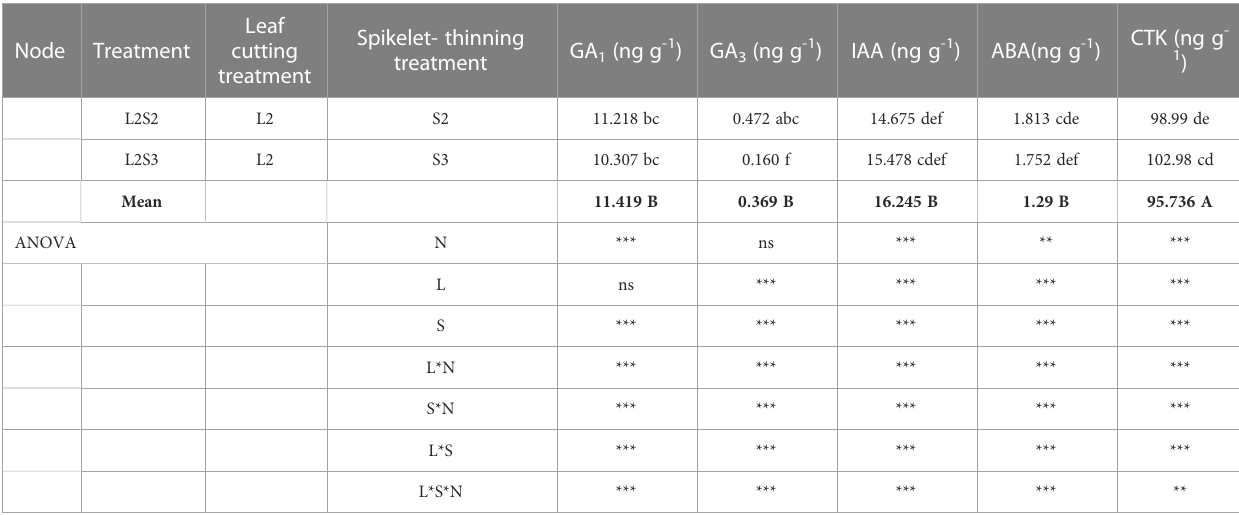
L0, represent the treatment of no leaf-cutting; L1, represents the treatment of cutting the fi rst leaffrom the top;L2, represent the treatment of cutting topthree leaves; S0, S1,S2 andS3 represent the treatment of thinning 0,1/4, 1/2and 3/4 spikelets, respectively. The content ofCTK was sum ofthe content of TZ9G, TZ, TZR, IP9G, IPR andIP. D2, D3 and D4 represent the second, third and lower than third nodes from the top, respectively. Data followed by different lower-case letters in the same node and different upper-case letters within one column denote signi fi cant differences between treatments at the 5% level according to LSD test. *** and ** represents the signi fi cant difference at the 0.1% and 1% level according to LSD test, respectively, ns represents no signi fi cant difference. The bold values represent the mean value of all treatment at separate